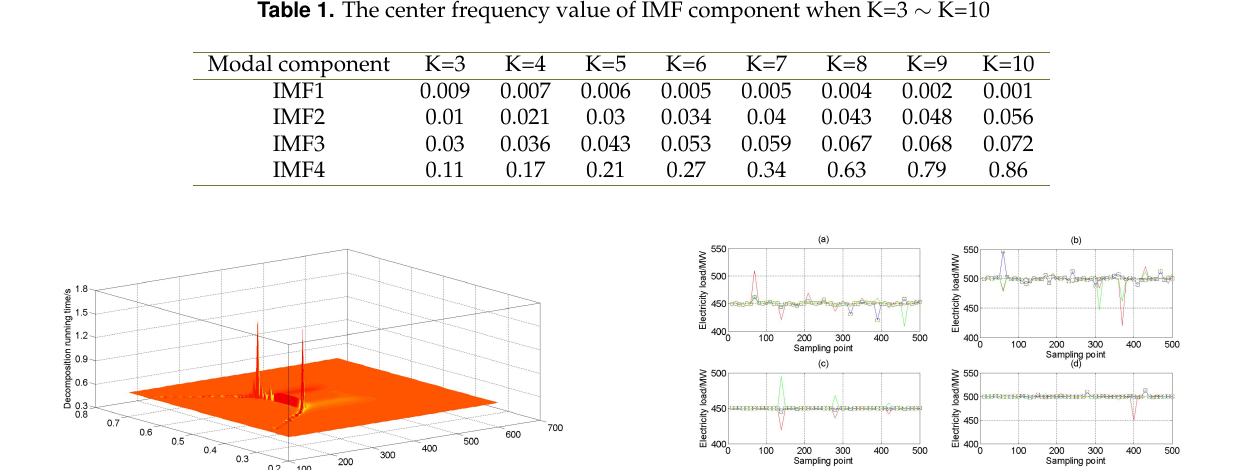
Table 1. The center frequency value of IMF component when K=3 ∼ K=10